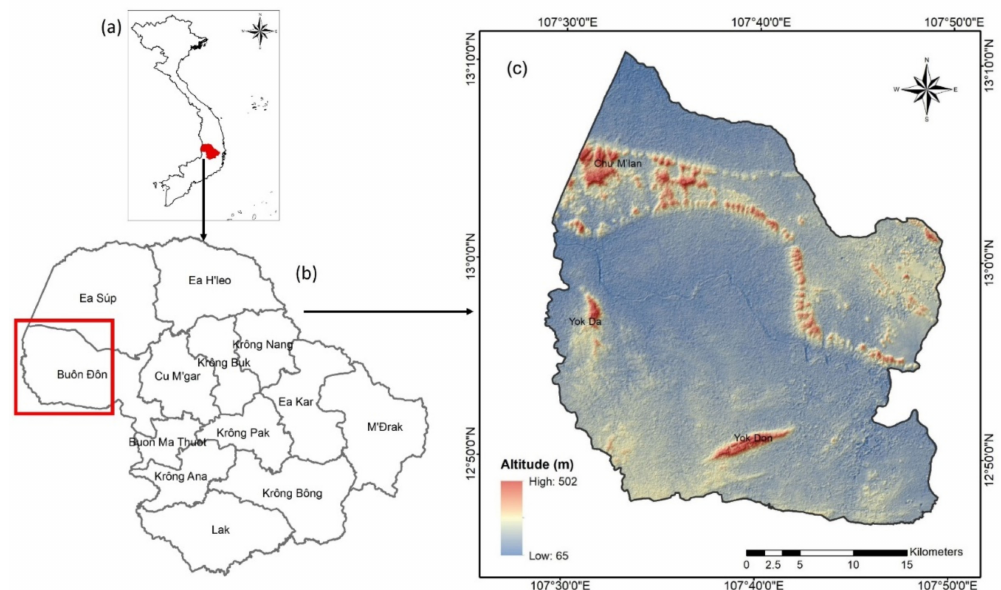
Figure 1. The study area in Yok Don National Park, Dak Lak Province, in the Central Highlands of Vietnam. ( a ) Vietnam administrative boundary; ( b ) administrative boundary of Dak Lak Province at district level and the study area located in red rectangle; and ( c ) topography of Yok Don National